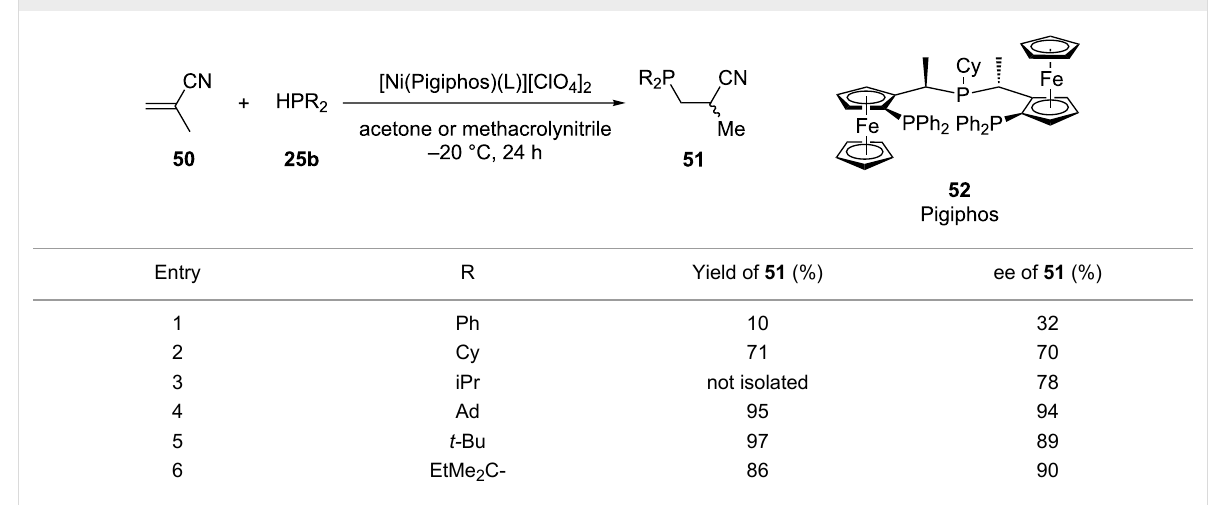
Table 3: Ni-catalyzed asymmetric hydrophosphination of methacrylonitrile 50 .